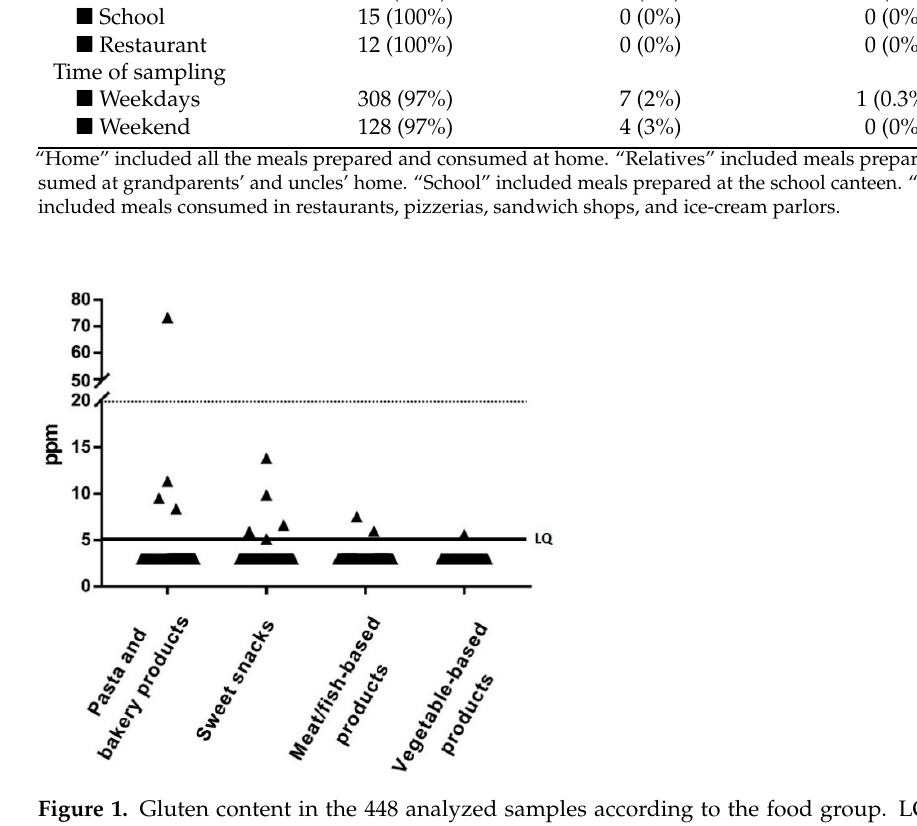
Figure 1. Gluten content in the 448 analyzed samples according to the food group. LQ, limit of quantification (solid line).